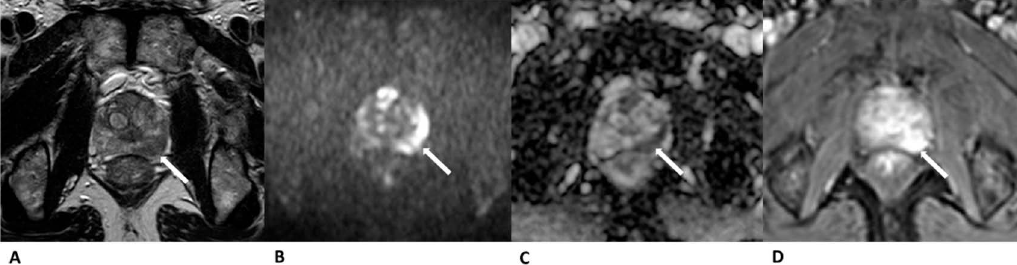
Figure 2. Case of prostate cancer in PZ. Male, 64 years old, prostate cancer with its longest diameter being >1.5 cm. T2WI showed a hypointense nodule in the left PZ (arrow) ( A ). The lesion was hyperintense on DWI (b = 1500 s/mm 2 ) (arrow)